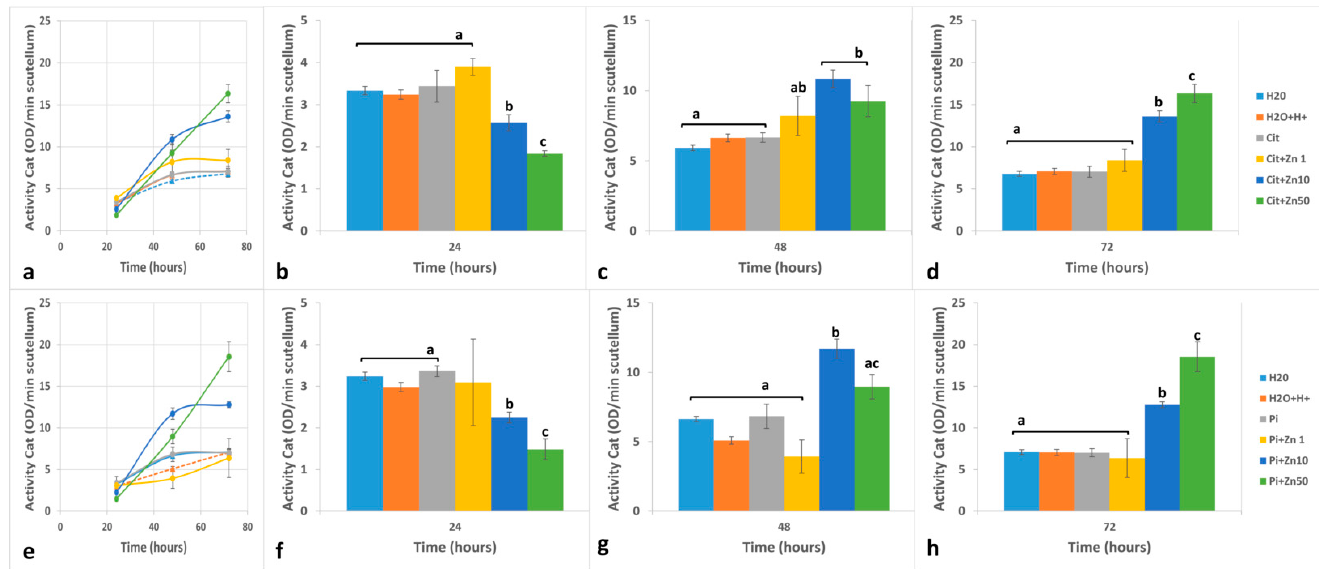
Figure 4. Effects of zinc on the activity of Peroxidase quantified with catechin + H 2 O 2 as substrates (POD-Cat) from maize scutellum. Embryos were imbibed for 24 to 72 h in H 2 O, H 2 O+H + , Cit, Cit+Zn1, Cit+Zn10, Cit+Zn50, Pi, Pi+Zn1, Pi+Zn10, or Pi+Zn50. Activity was determined using catechin + H 2 O 2 as substrates in ( a ): Cit or ( e ): Pi. Imbibition times were ( b , f ): 24 h; ( c , g ): 48 h; and ( d , h ): 72 h, in Cit or Pi, respectively. The data represent the mean ± SE of n = 3 to 6 independent assays. ANOVA was performed, followed by the Tukey–Kramer multiple comparison test, with p < 0.05 representing significance. Letters that are the same indicate similar variations, and the different letters indicate significant changes at each imbibition time.